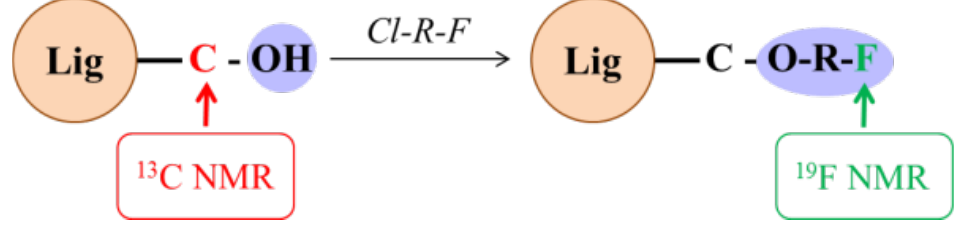
Figure 1. A schematic reaction of lignin fluorobenzylation ( Cl-R-F — 4-Fluorobenzylchloride, Lig —